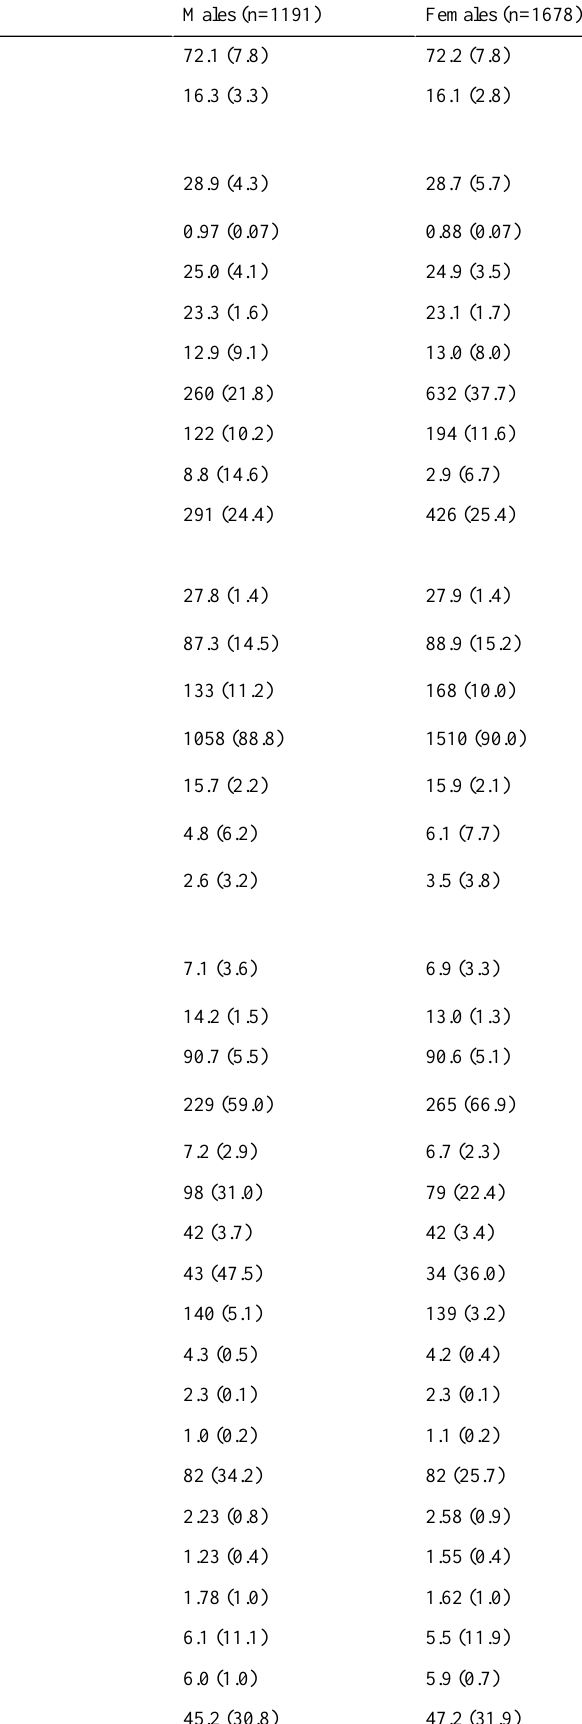
Table 1. General characteristics of the Trinity-Ulster and Department of Agriculture study